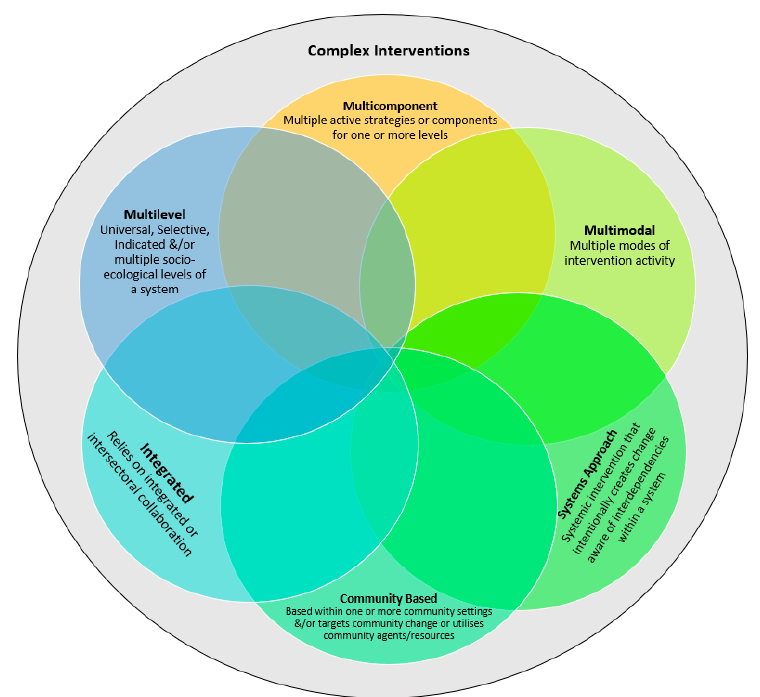
Figure 1. Characteristics of complex